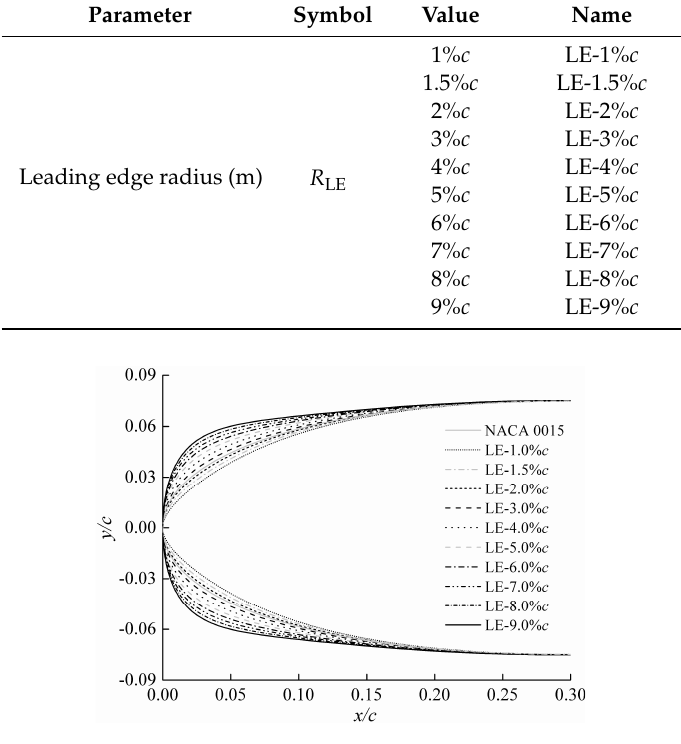
Figure 1. Geometric profiles of the airfoils with modified leading edge.